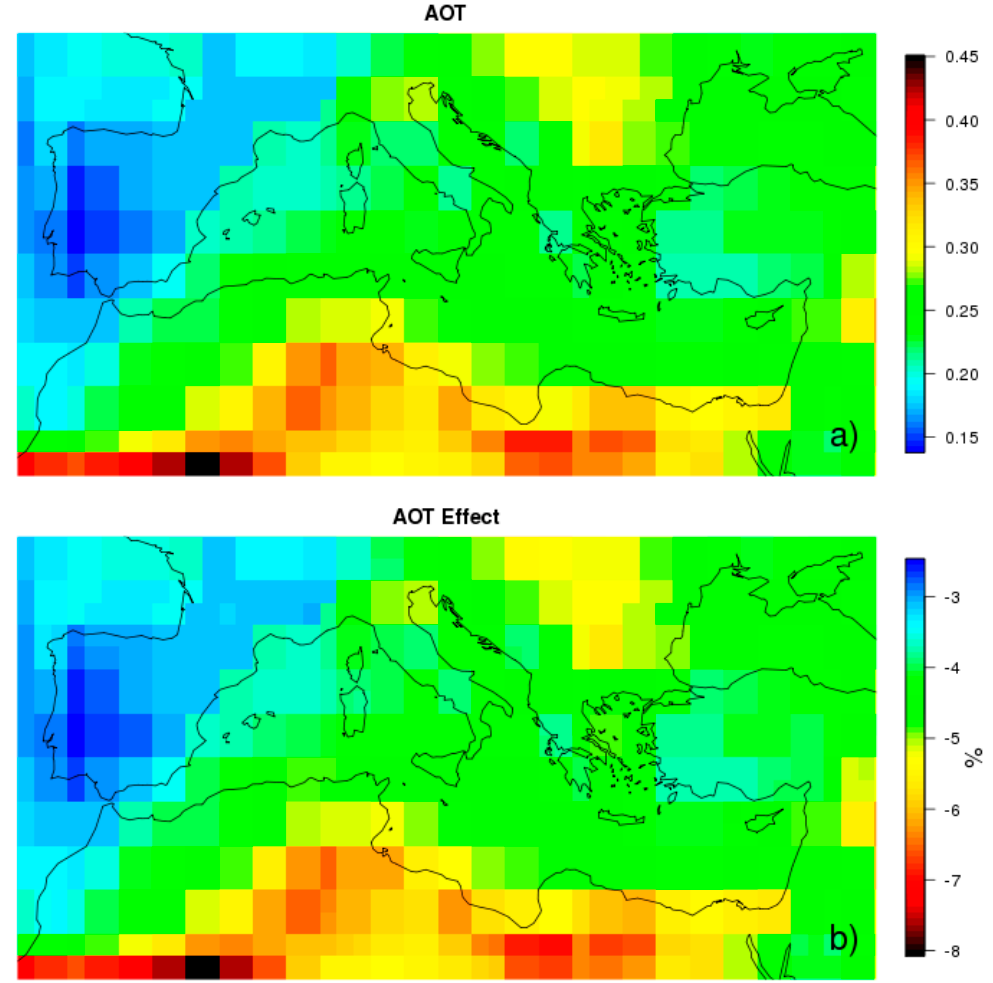
Figure 1. Distribution of averaged (a) AOT and (b) AOT effects on shortwave radiation at the surface over the Mediterranean basin during the period 2000–2018.